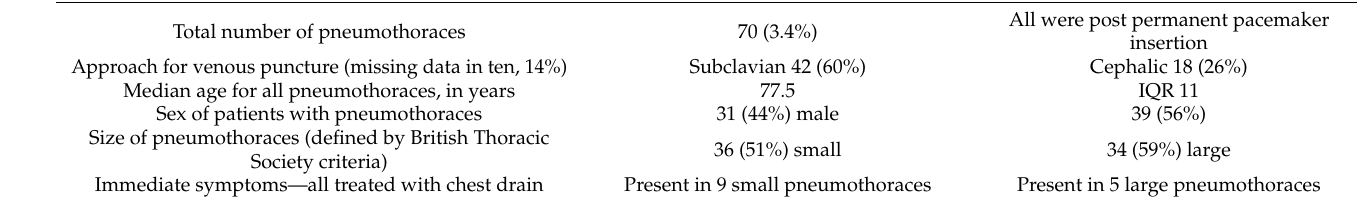
Table 1. Characteristics of study population: British Thoracic Society (BTS) criteria for pneumoth- orax categorisation: differentiation of a “large” from a “small” pneumothorax is the presence of a visible rim of more than two centimetres (cm) between the lung margin and the chest wall on a chest